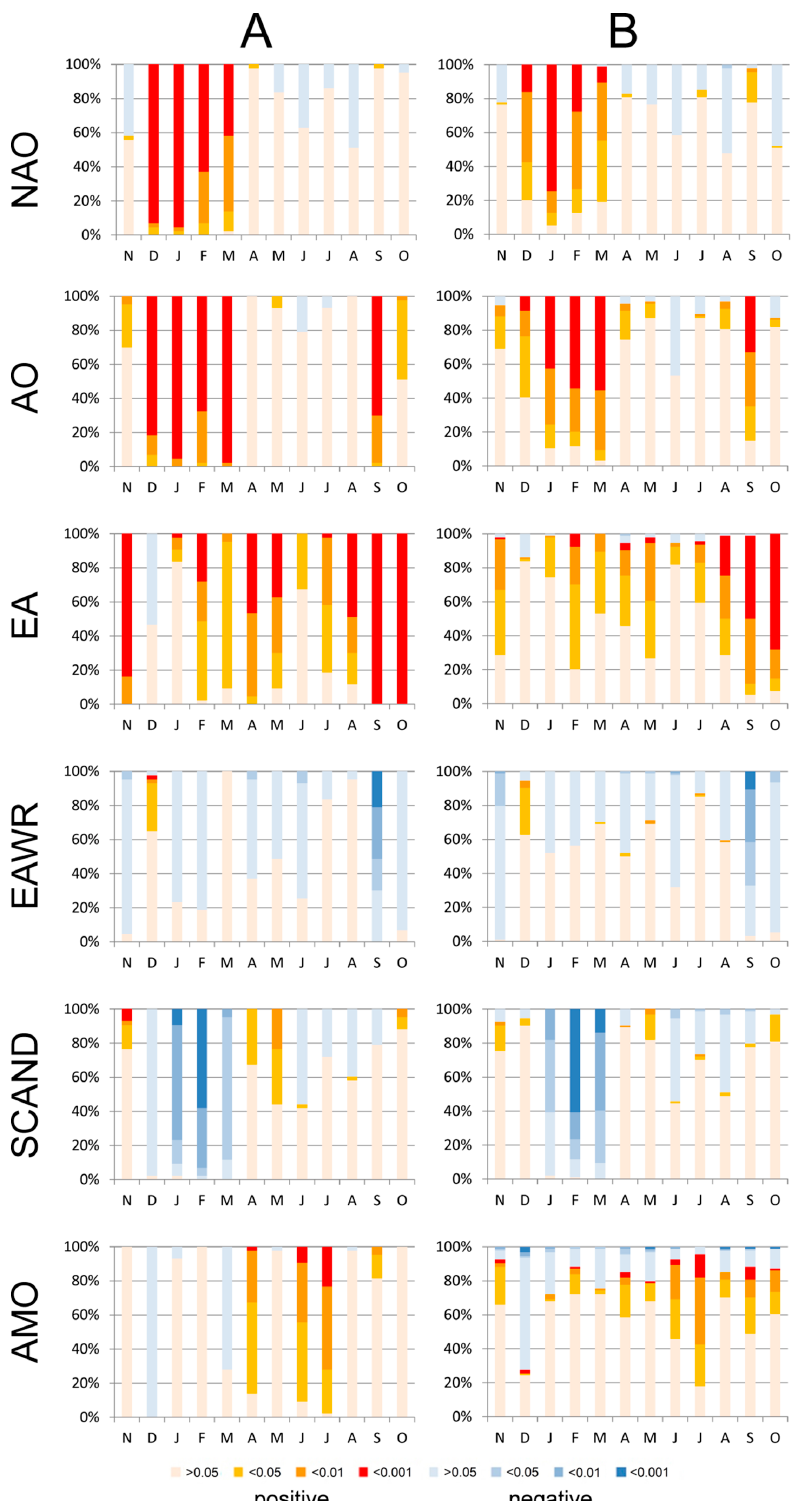
Figure A1. Percentage share of positive and negative coefficients of correlation of monthly indices of macroscale circulation types with air temperature ( A ) and river water temperature ( B ).